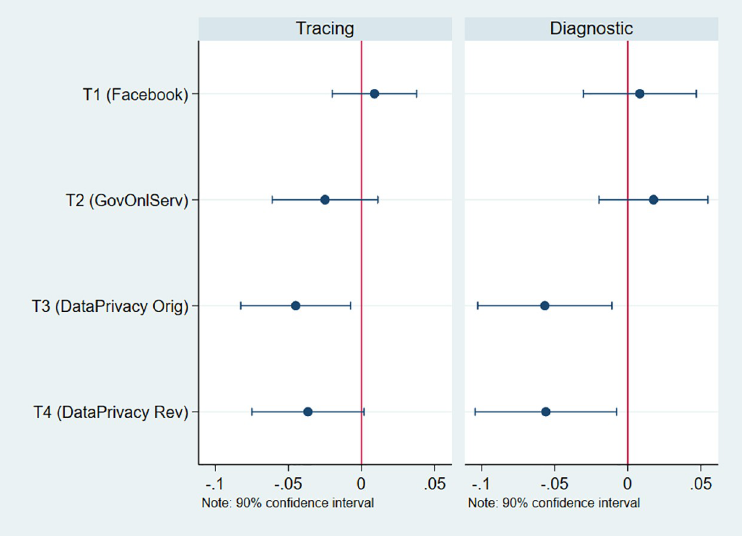
Fig 3. Treatment effects—Sonora Sample. This figure shows the treatment effects and coefficients for the two dependent variables. Correspond to columns [1] and [4] in S3 Table.